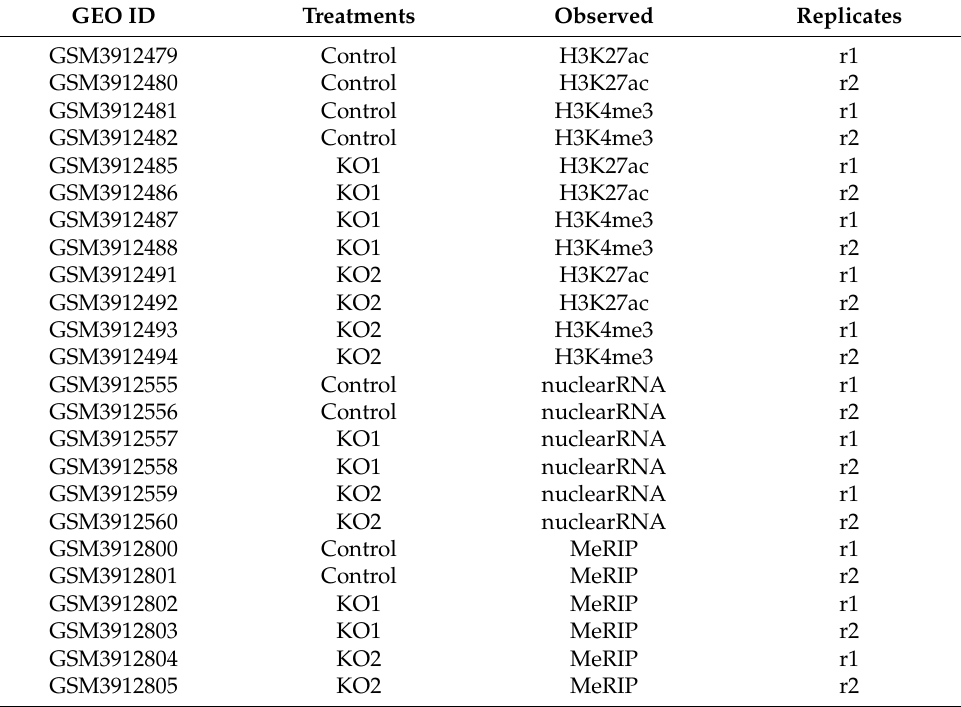
Table 2. Sample tables for